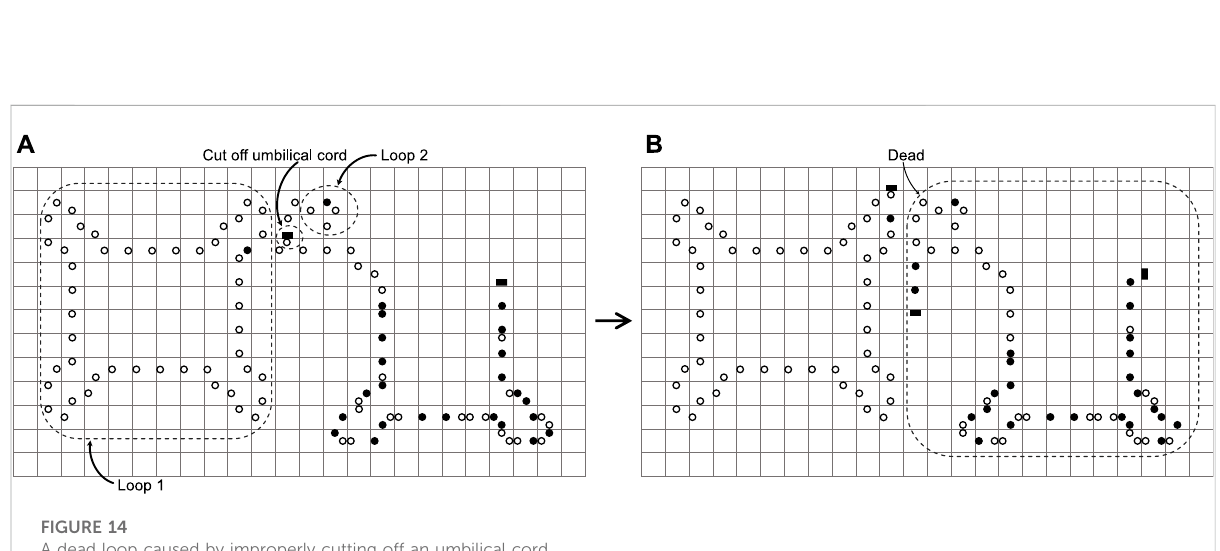
FIGURE 14 A dead loop caused by improperly cutting off an umbilical